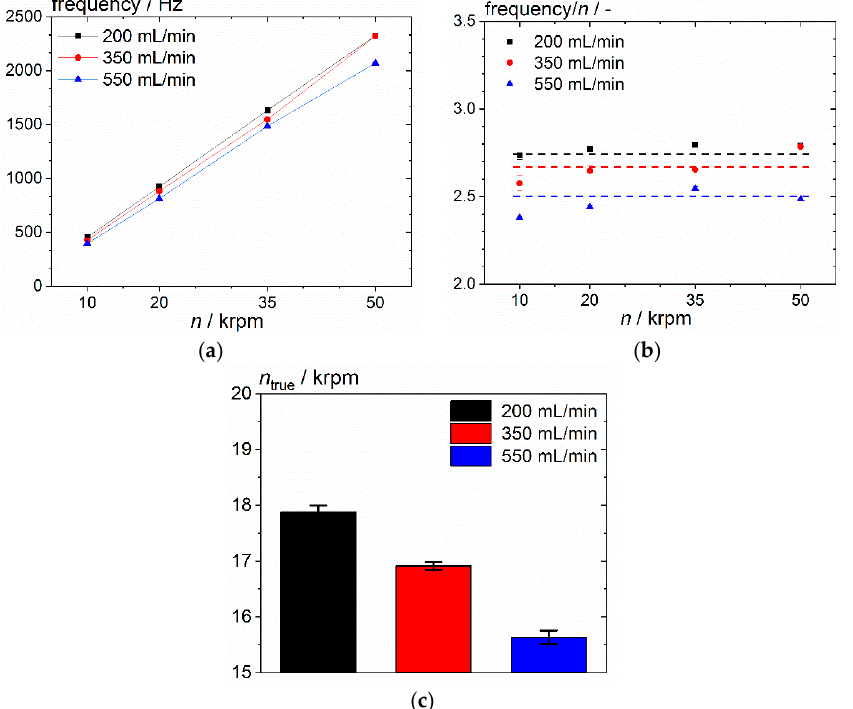
Figure 6. ( a ) Fundamental pulsation frequency vs. nominal rotational speed n for different volumetric flow rates (cid:1848)(cid:4662) . ( b ) Pulsation frequency/ n vs. nominal rotational speed n for different volumetric flow rates (cid:1848)(cid:4662) . The lines are to guide the eye. ( c ) True rotational speed n true for different volumetric flow rates (cid:1848)(cid:4662) during atomization at a nominal rotational speed of n = 20 krpm.